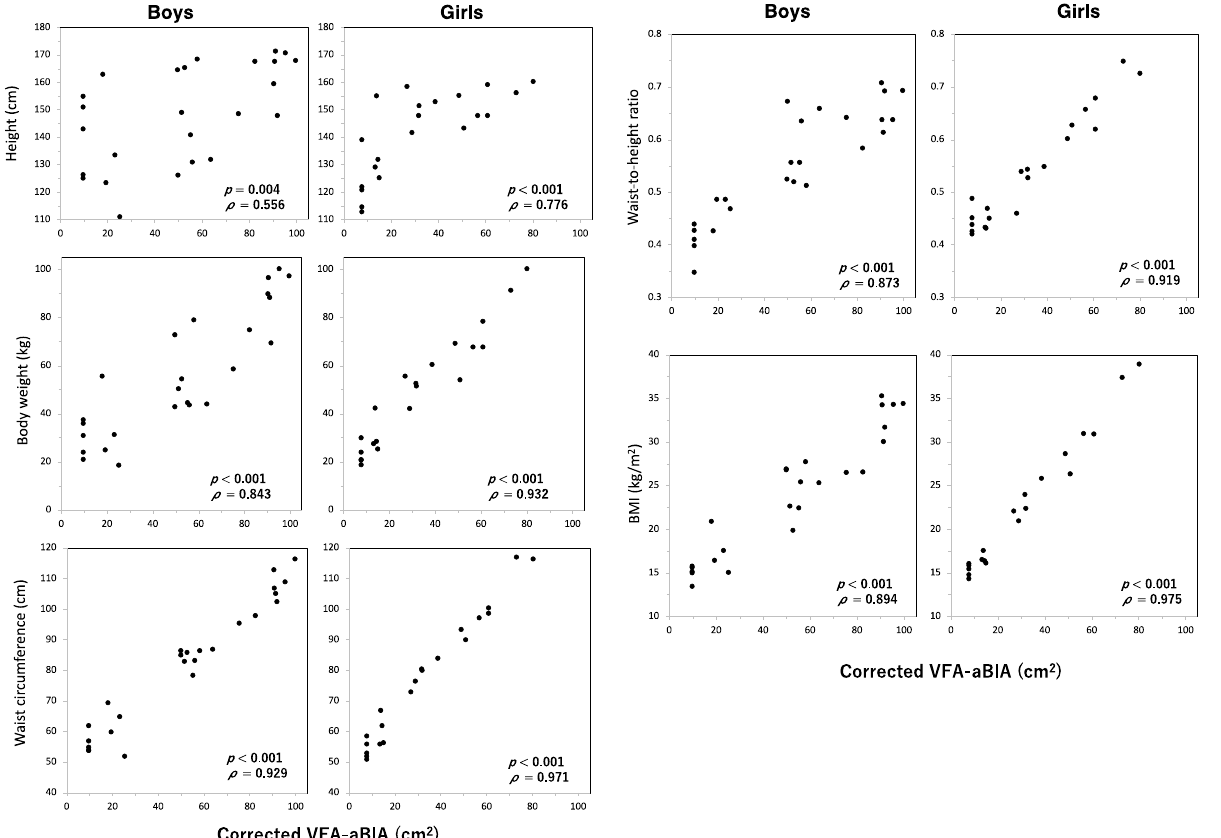
Figure 5. Relationship between corrected VFA-aBIA and height, body weight, waist circumfer- ence, waist-to-height ratio, or body mass index. VFA-aBIA—visceral fat area measured by ab- dominal bioelectrical impedance analysis using EW-FA90 (Panasonic Corporation, Osaka, Japan); BMI—body mass index.